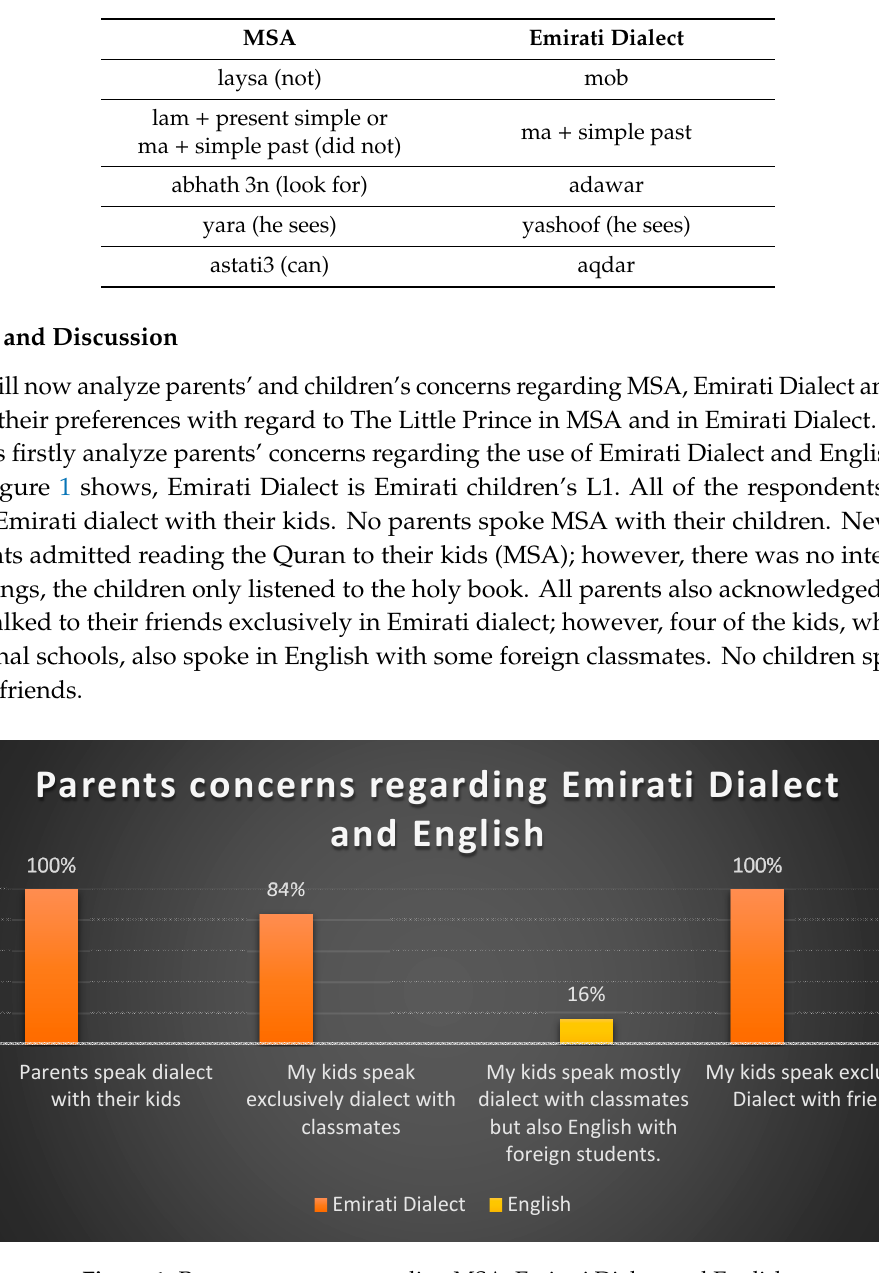
Figure 1. Parents concerns regarding MSA, Emirati Dialect and English.